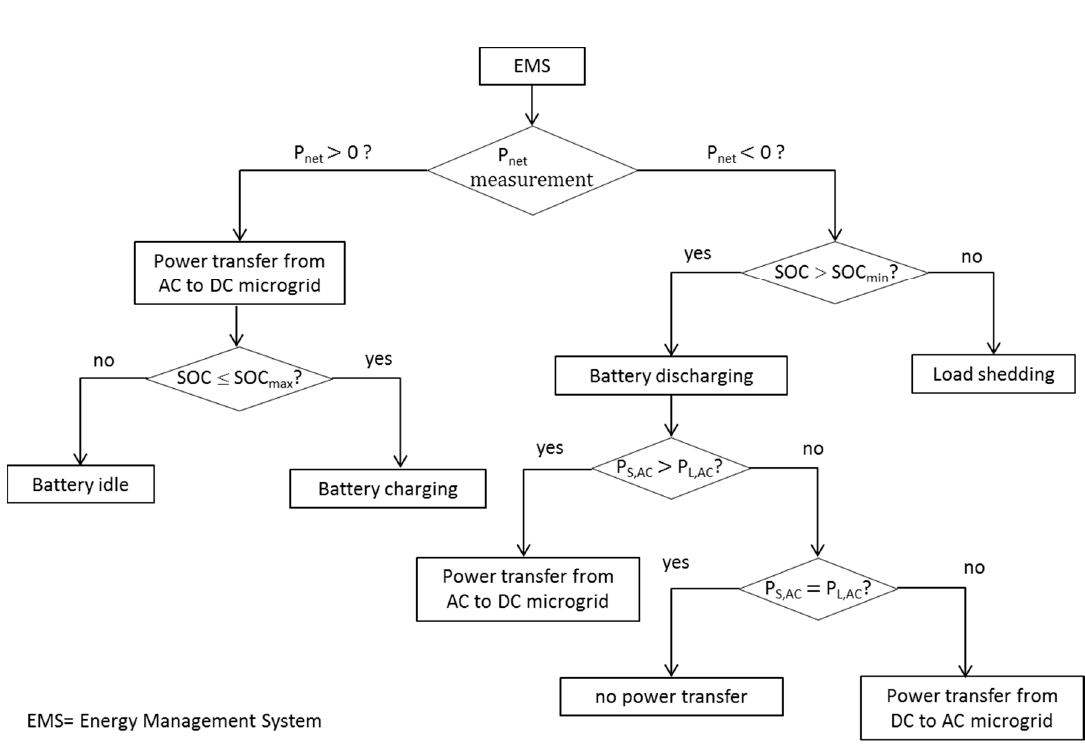
Figure 12. Power management under stand ‐ alone operation.